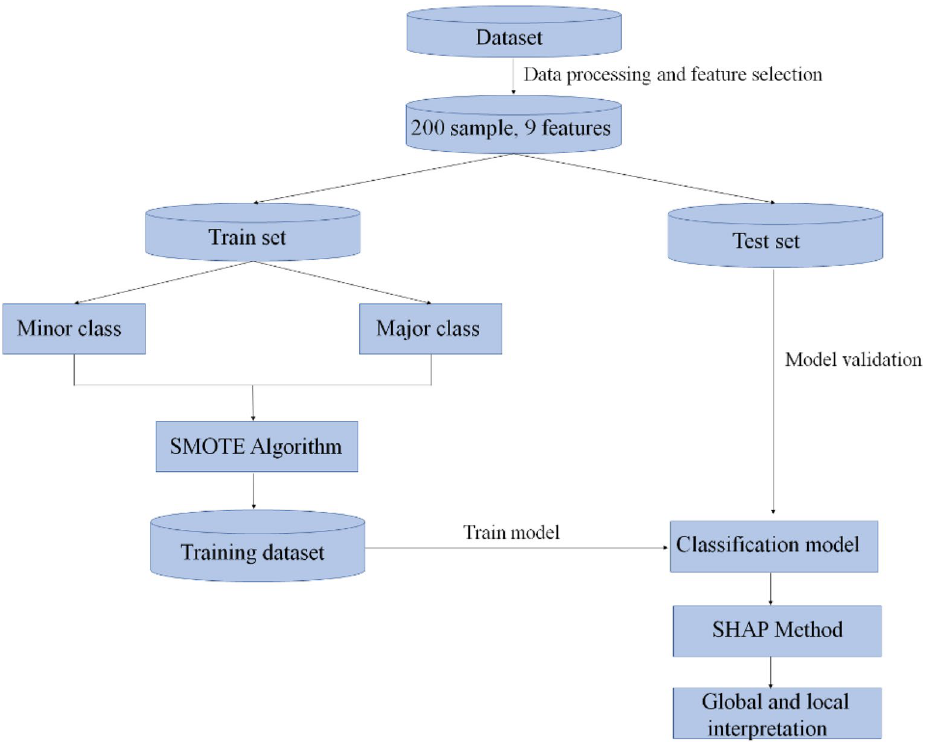
Figure 1. Overview of the proposed